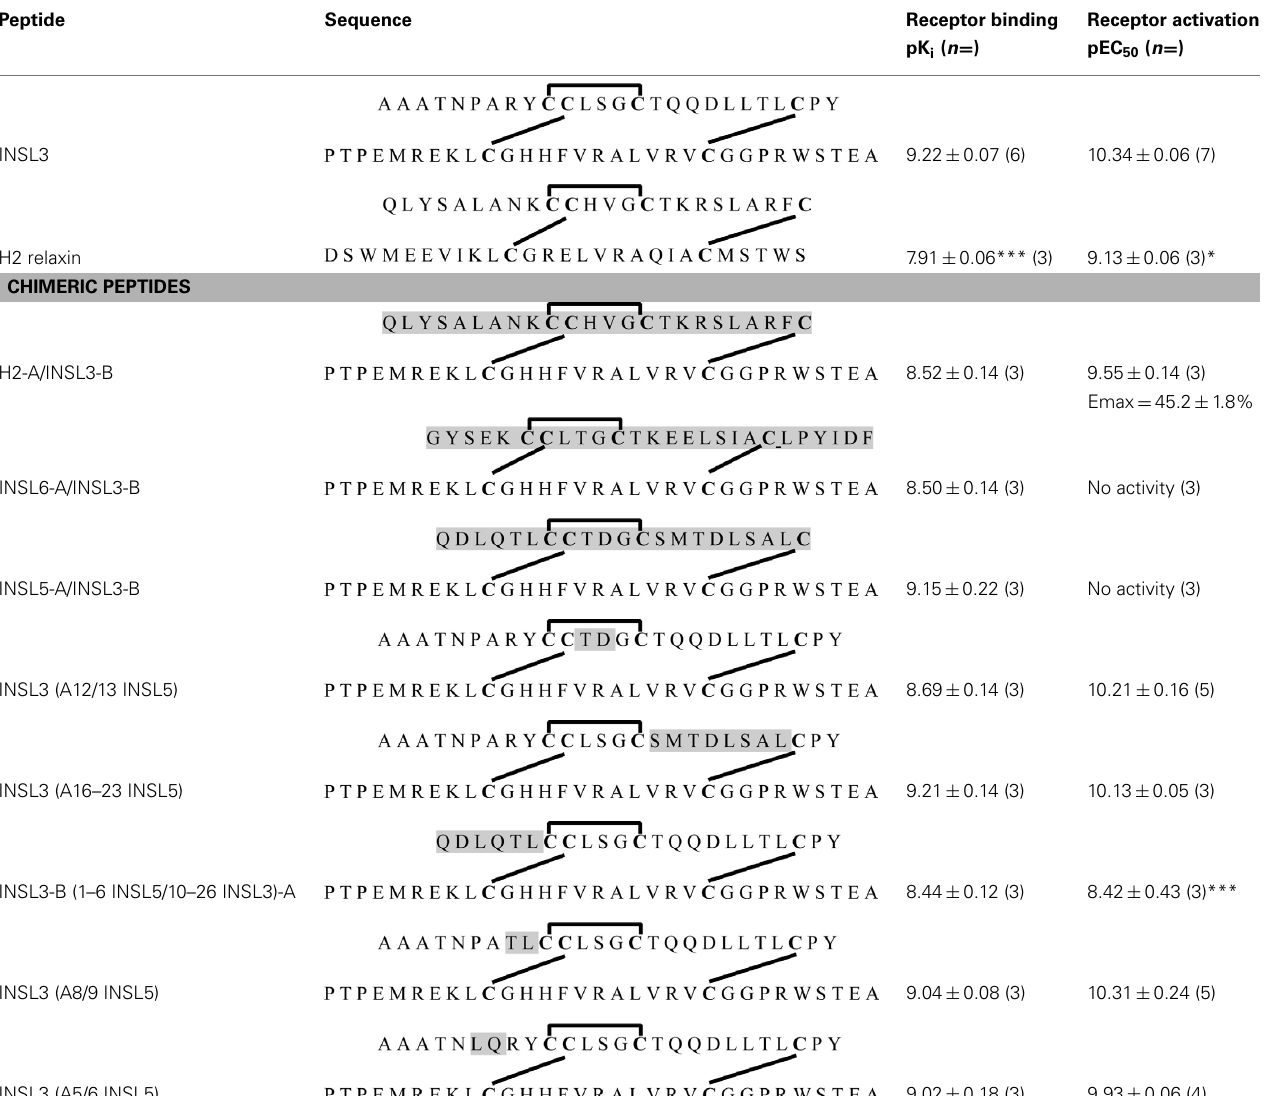
Table 1 | Sequences and receptor binding affinities (pKi) and receptor activation (pEC50) activities of INSL3, H2 relaxin, and INSL3 chimeric